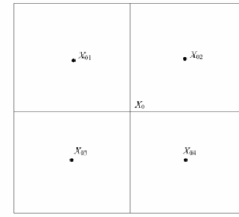
Figure 5. Sketch map for upscaling transformation